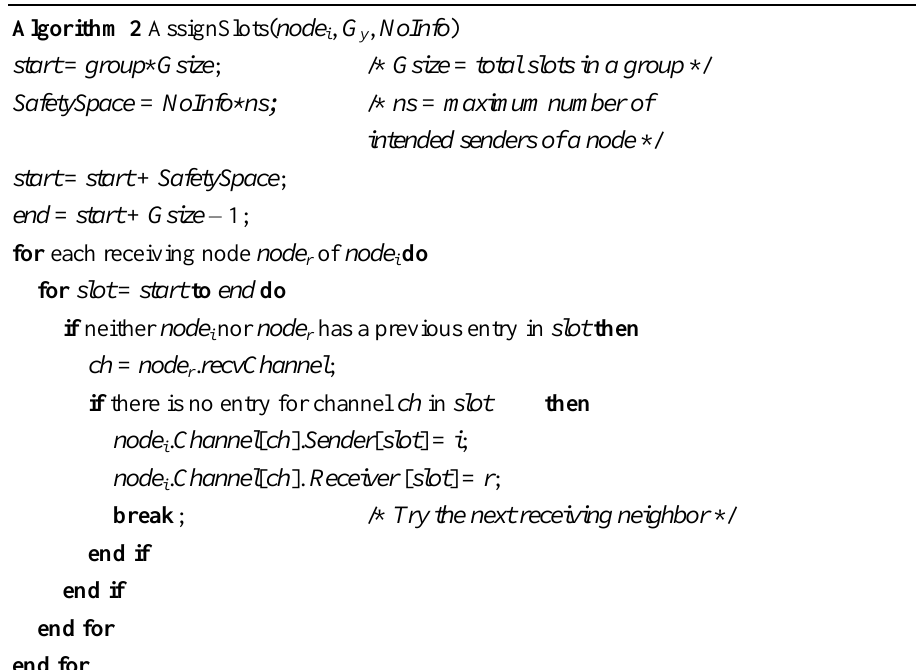
Algorithm 2 AssignSlots( node